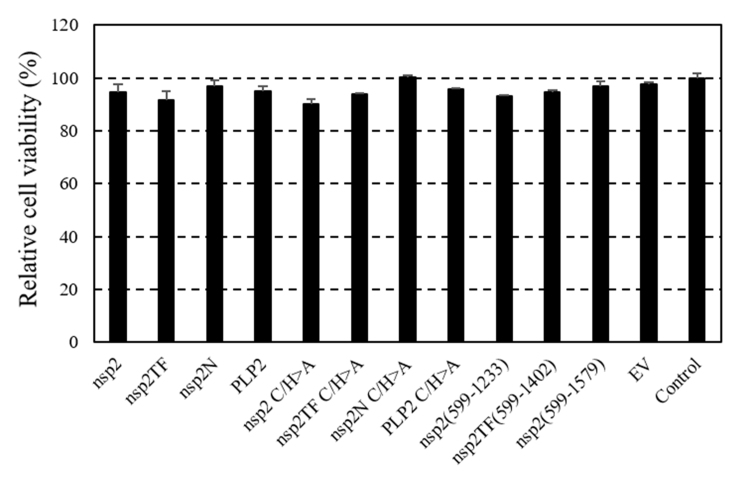
Effect of nsp2-related proteins on HEK-293T cell viability. Cell viability was determined using a CellTiter 96 AQueous cell proliferation assay (Promega). Viability of transfected cells were compared to that of untreated control cells (100%). The average and standard deviation (SD) of a representative experiment are shown. All experiments were repeated twice, and triplicates were performed at each time.